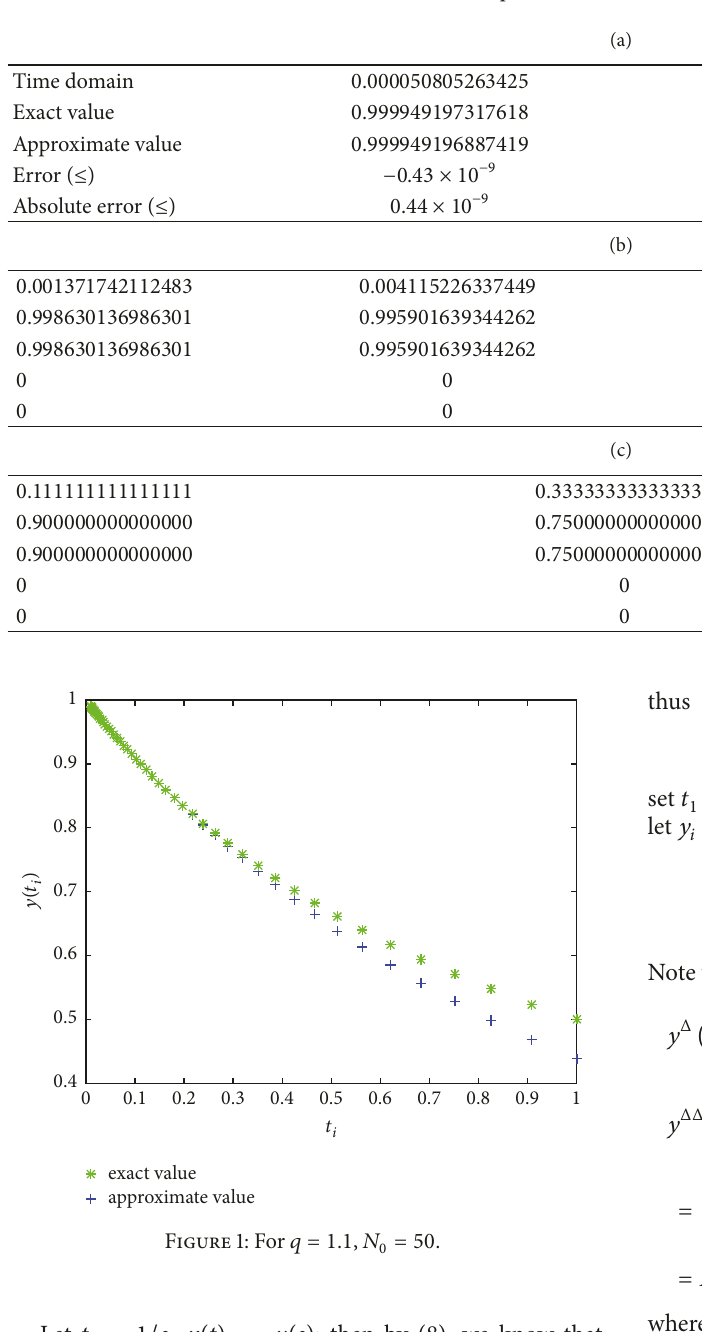
Table 1: The comparison of exact value and approximate value.